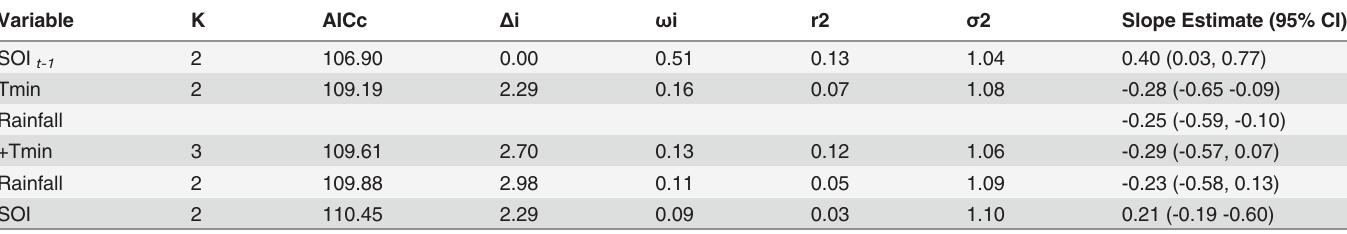
ω 2 = regression i ) = AIC weight, r